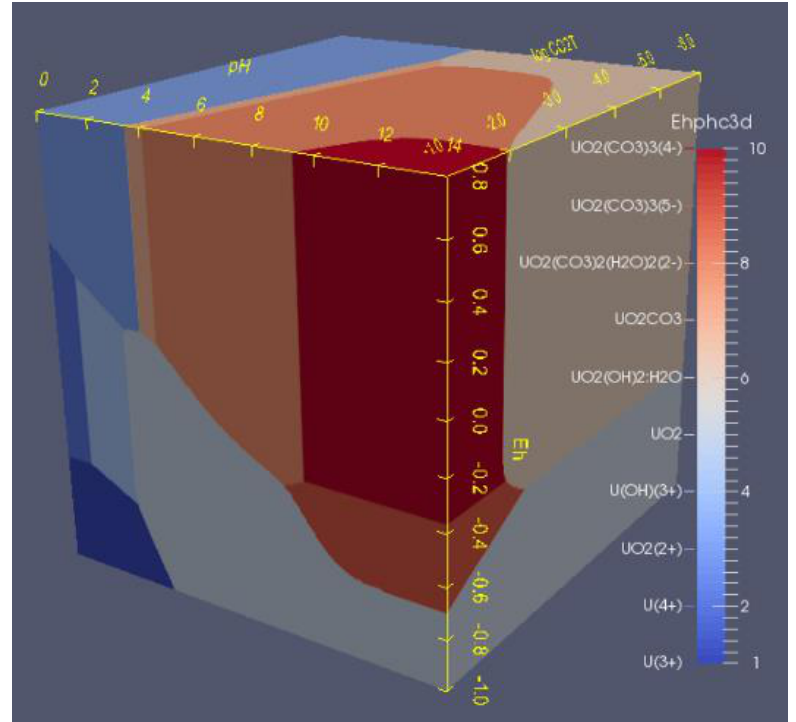
Figure 27. Eh-pH-log Σ CO 2 of uranium where the species are shown by colors. A color bar is inserted to show the corresponding species.